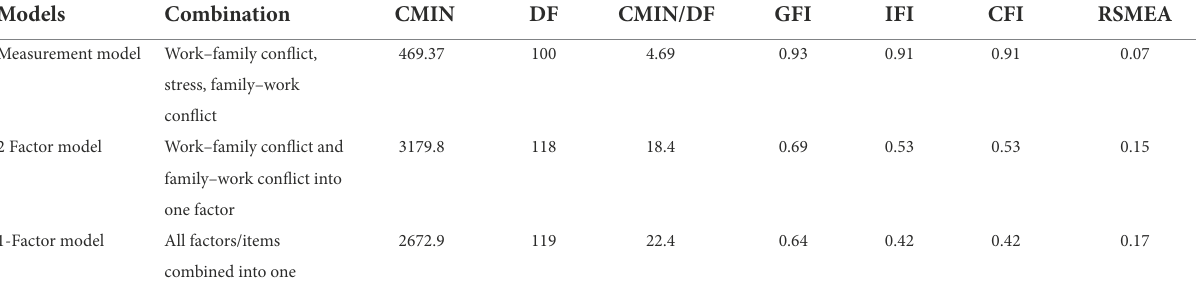
TABLE 1 Comparison of measurement and alternative models fit indices.